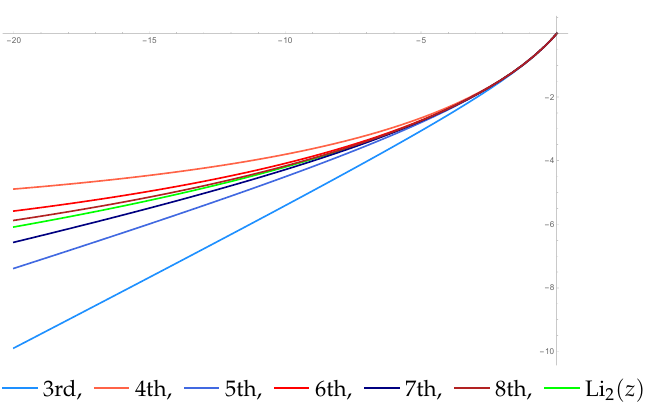
Figure 1. The plots of values of the n th approximants of (50) for Li 2 ( z ) .